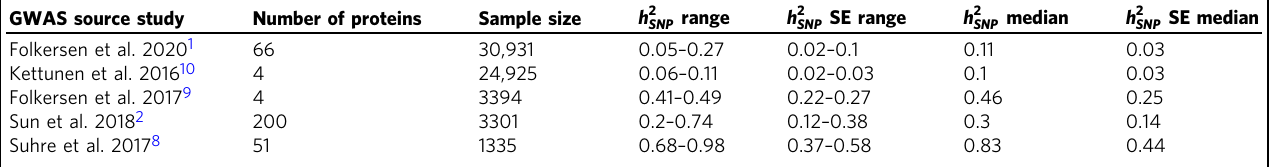
Pleiotropic genes in fl uencing migraine and blood protein levels . We used MAGMA gene-based analysis; 15 fi rst, to assign SNPs to 18,236 protein-coding genes; second, to estimate the association P -value for each gene ( P gene ), for migraine and the included 325 blood proteins. Migraine- and protein-associated genes were de fi ned at P gene ≤ 0.05/18,236. To study the presence of pleiotropy between migraine and blood protein levels at the gene level, we tested if genes associated with migraine risk are statistically enriched in the genes associated with blood protein levels using the Exact Binomial Test . The alternative hypothesis was that the observed proportion (the number of genes associated with both migraine and the protein divided by the number of genes associated with the protein) is greater than the null pro- portion(the number of genes associated with migraine [494] divided by the number of all genes [18,236]). More details are provided in the Methods section. This analysis revealed that